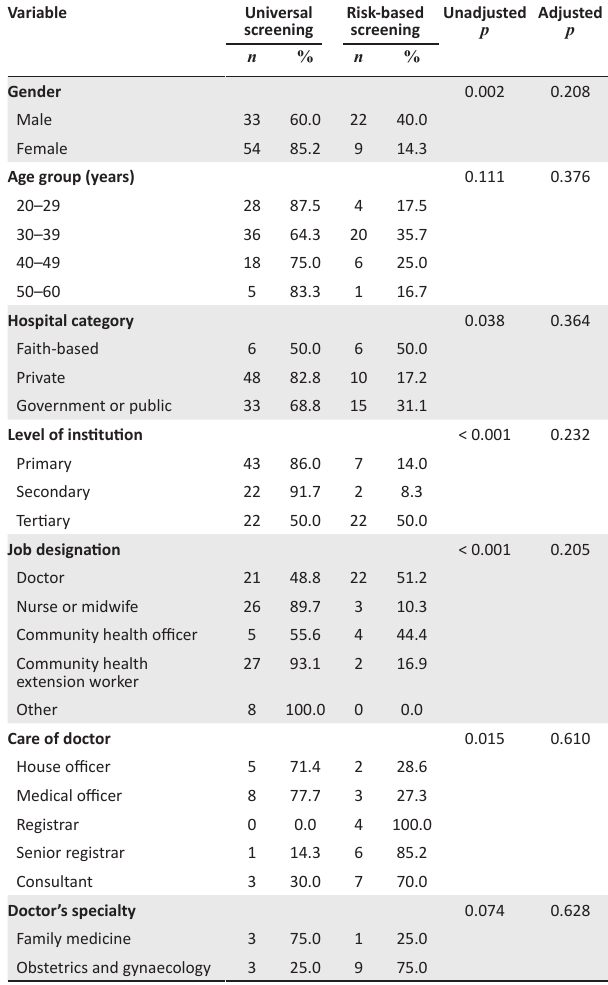
TABLE 3: Factors associated with universal or risk-based screening using binary logistic regression analysis among antenatal healthcare providers in healthcare facilities in Jos North, Plateau state, Nigeria, August to September